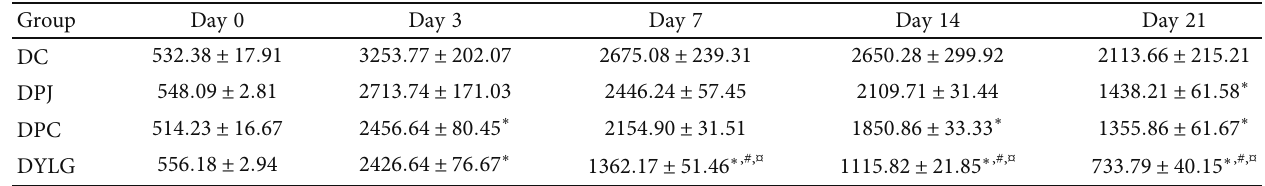
Table 5: The blood NF- κ B levels (ng/ml) in T2DM rats on days 0, 3, 7, and 14 ( n = 24 per group). Group